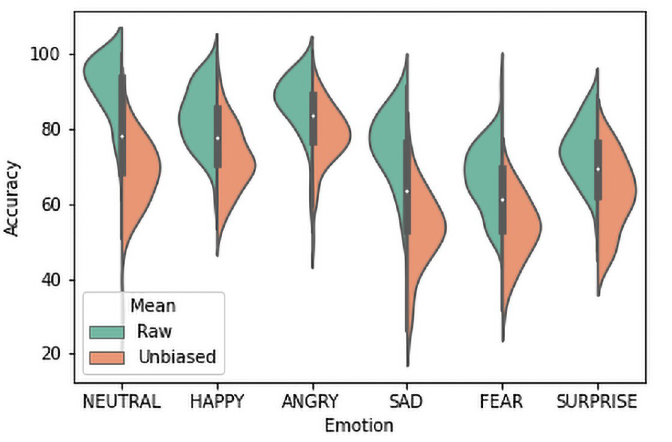
were six options for each rating to the users the chance level of responses for this phase is 17%. Recognition scores for all emotion categories were higher than 17%. Raw and unbiased hit rates are compared in Fig 4 for Phase 2. Sentence-wise recognition rates for all emotions for this phase is represented in Table 10.